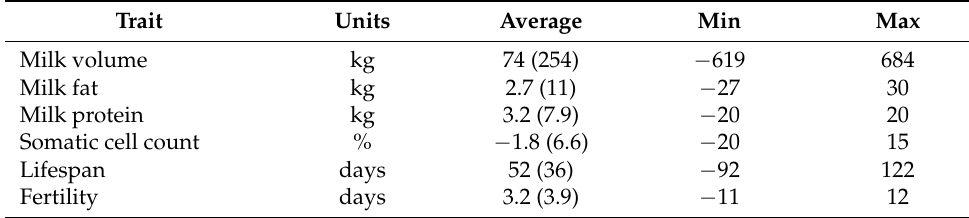
Table 3. Average (s.d.) predicted transmitting ability per animal.